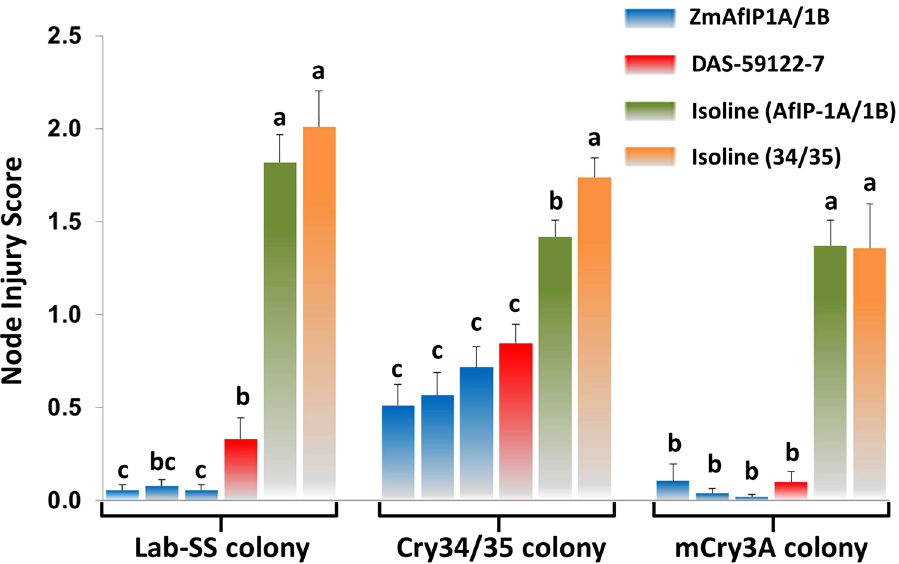
Figure 3. Laboratory-selected WCR confirm similar mode of action of AfIP-1A/1B to Cry34/35 but not to mCry3A. Injury from larval feeding to AfIP-1A/1B maize events by Cry34/35- and mCry3A- selected WCR populations was visually assessed using the 0–3 Iowa State node-injury scale 20 . Means and 95% confidence intervals followed by different letters within insect populations differed significantly (P ≤ 0.05) by using a linear mixed